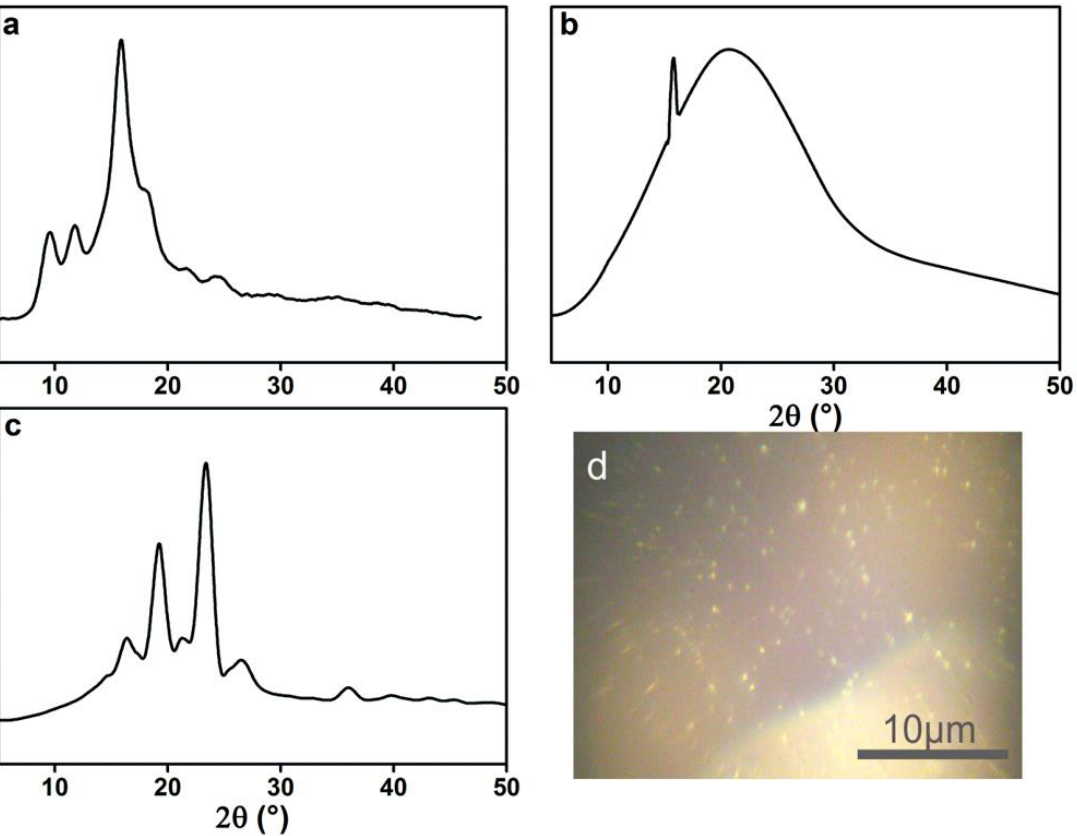
Figure 5. XRD patterns of ( a ) acrylic rosin ( b ) PEG-acrylic rosin polymer obtained from 2 g L − 1 solution at 85 °C and ( c ) 0.5 g L − 1 solution at 5 °C respectively. ( d ) POM micrographs of the crystallization of PEG-acrylic rosin solution at 5 °C.